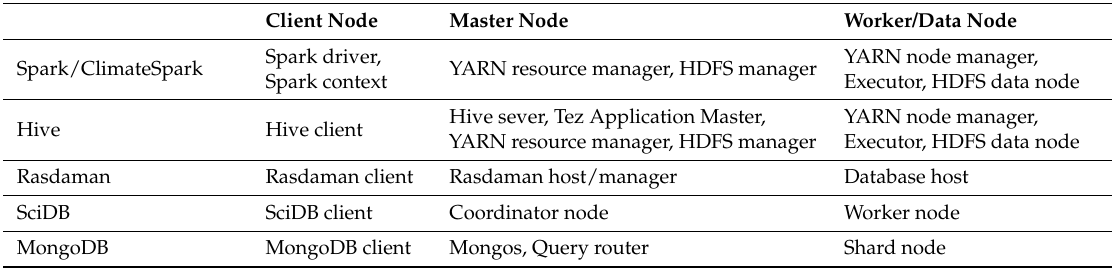
Table 1. Thespecificterminologiesthedatacontainersuseforclientnode,masternode,andworker/datanodes.